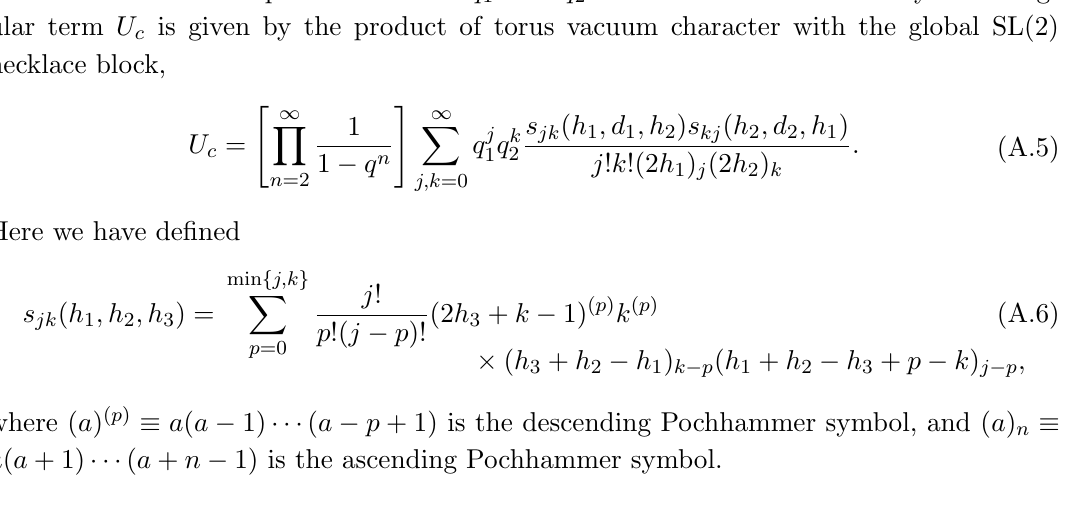
from which a series expansion of F in q